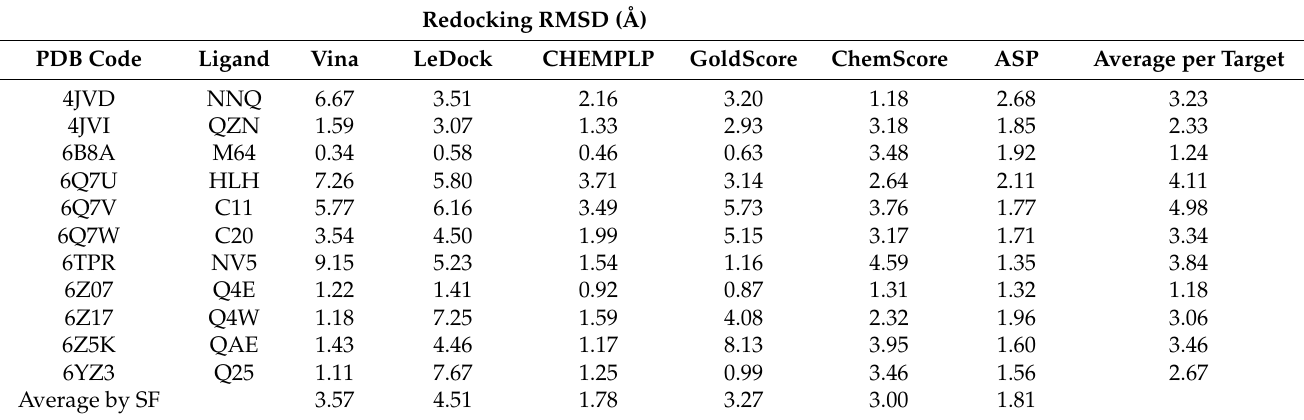
Table 1. RMSD of the re-docking for the other targets and their respective crystallographic ligand. Redocking RMSD